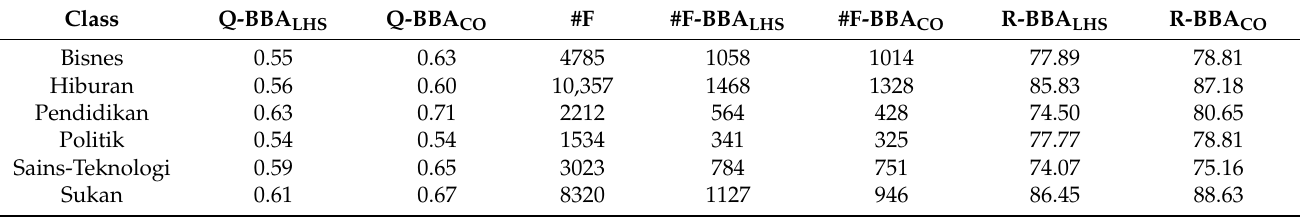
Table 16. Characteristics of the selected feature sets in Mix-DS, where Q indicates the quality of feature set, #F indicates to number of features, R indicates reduction rate